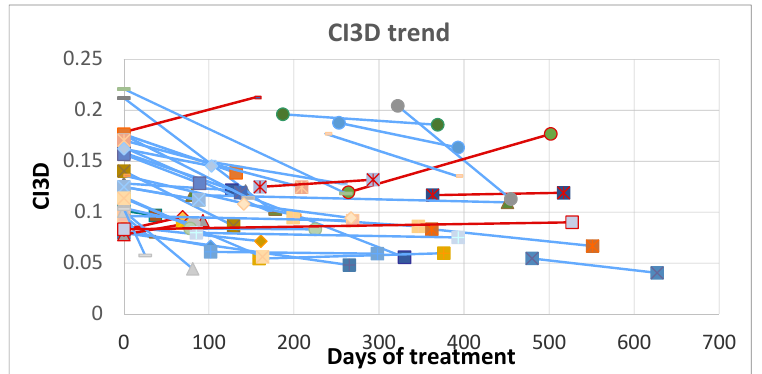
Figure 7 . CI3D trends during VB treatment. The Y axis indicates the number of days of VB therapy treatment, while the X axis indicates the value of the CI3D at the time of measurement. Blue and red lines indicate a CI3D value reduction or increase, respectively, during treatment.